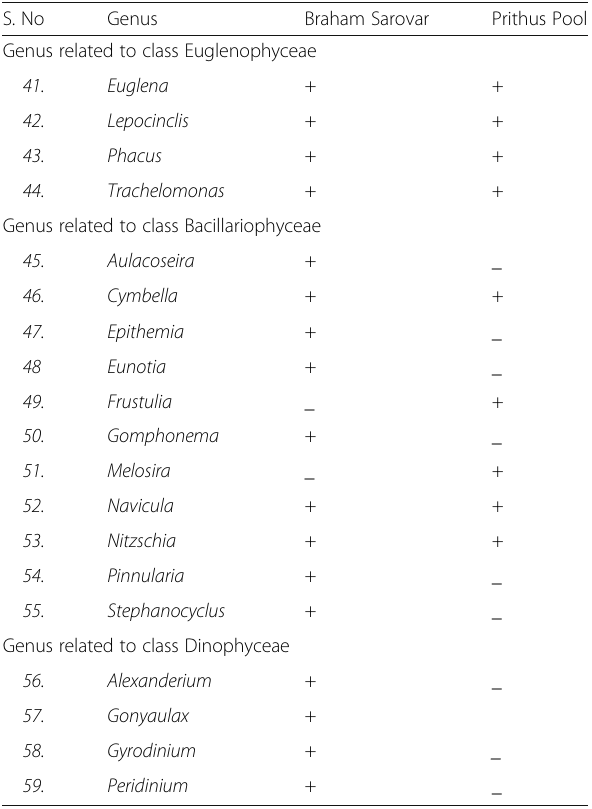
Table 6 List of genera observed in Braham Sarovar and